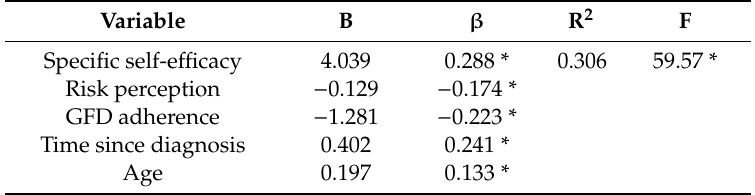
Table 7. Linear regression analysis predicting HRQoL.